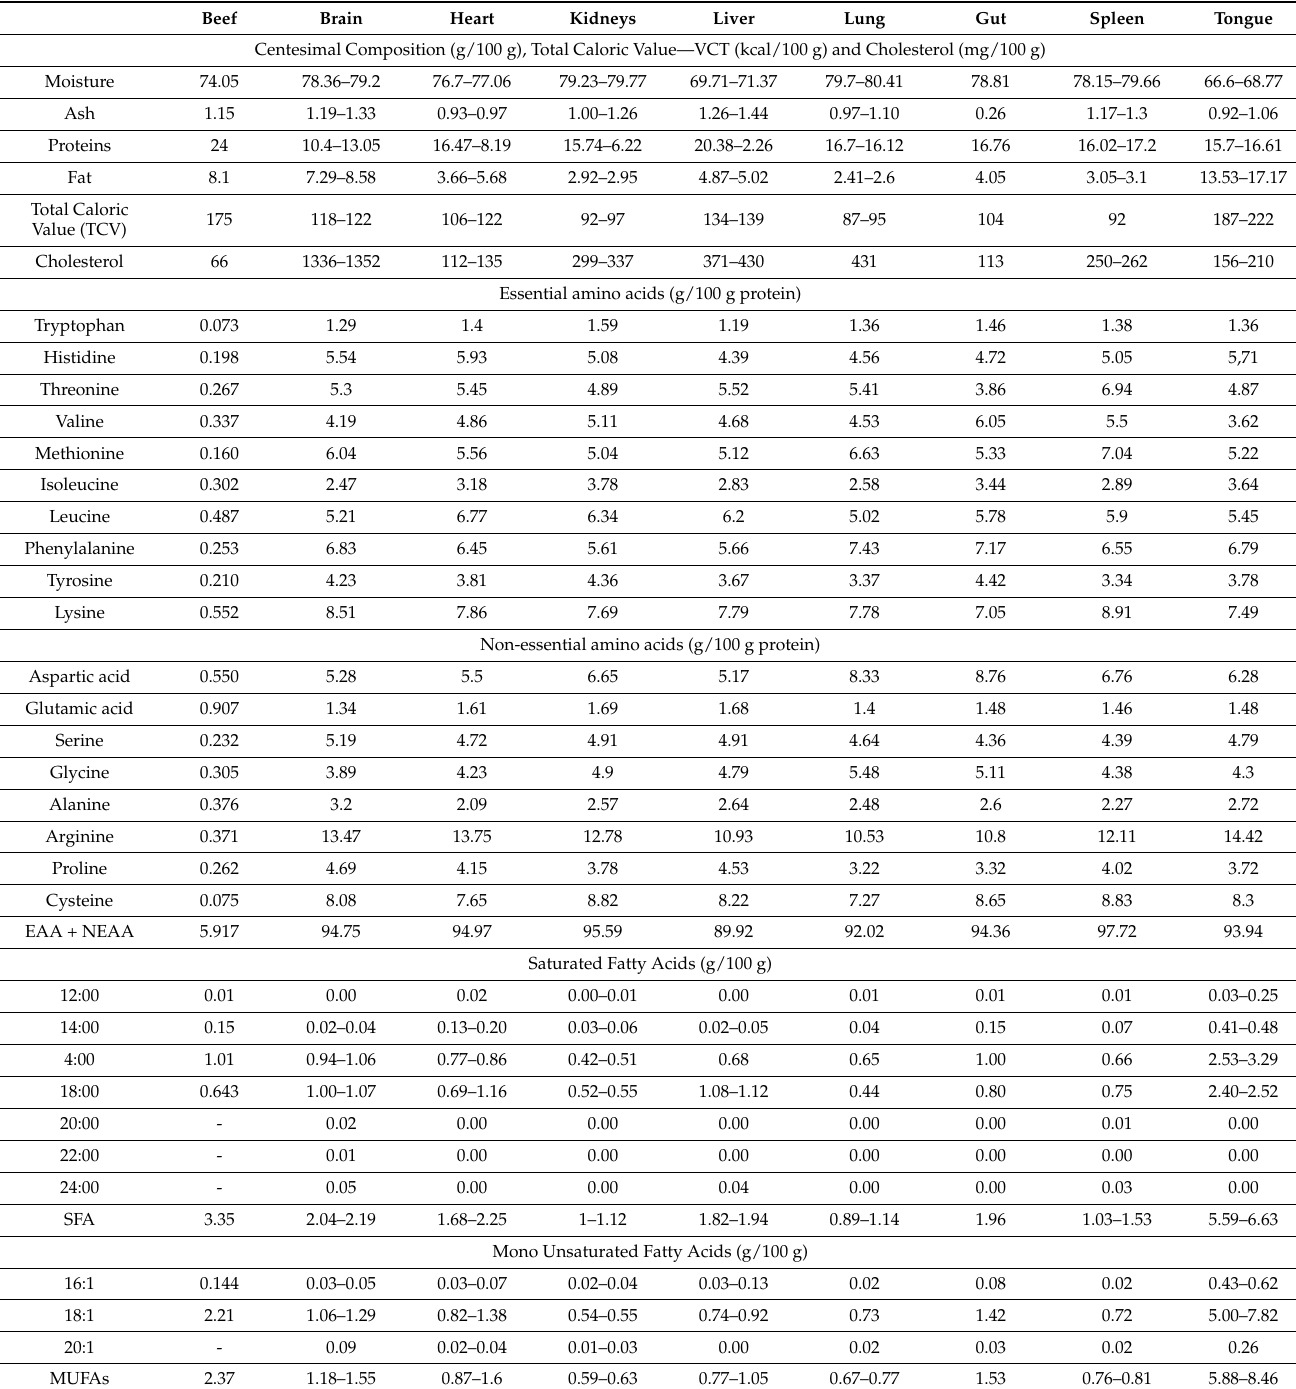
Table 2. Nutritional composition of sheep meat and edible